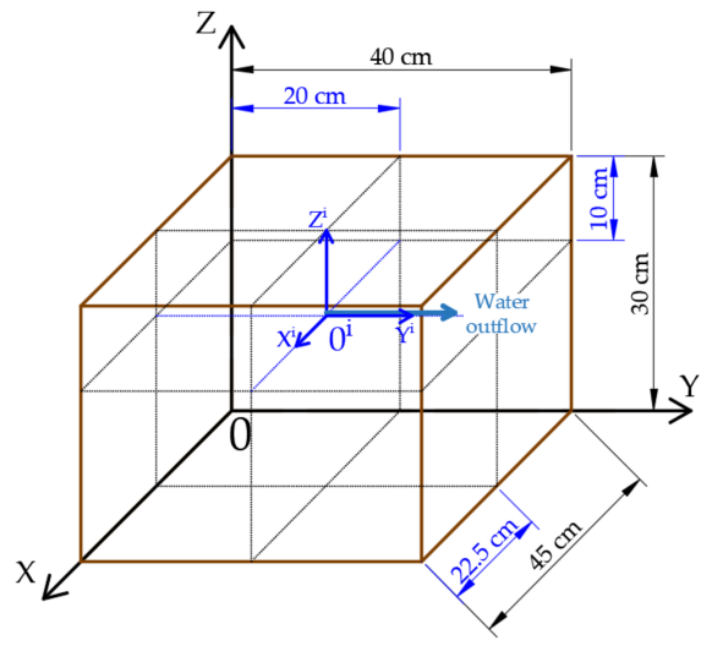
Figure 3. The space of the physical model in dimetric projection .